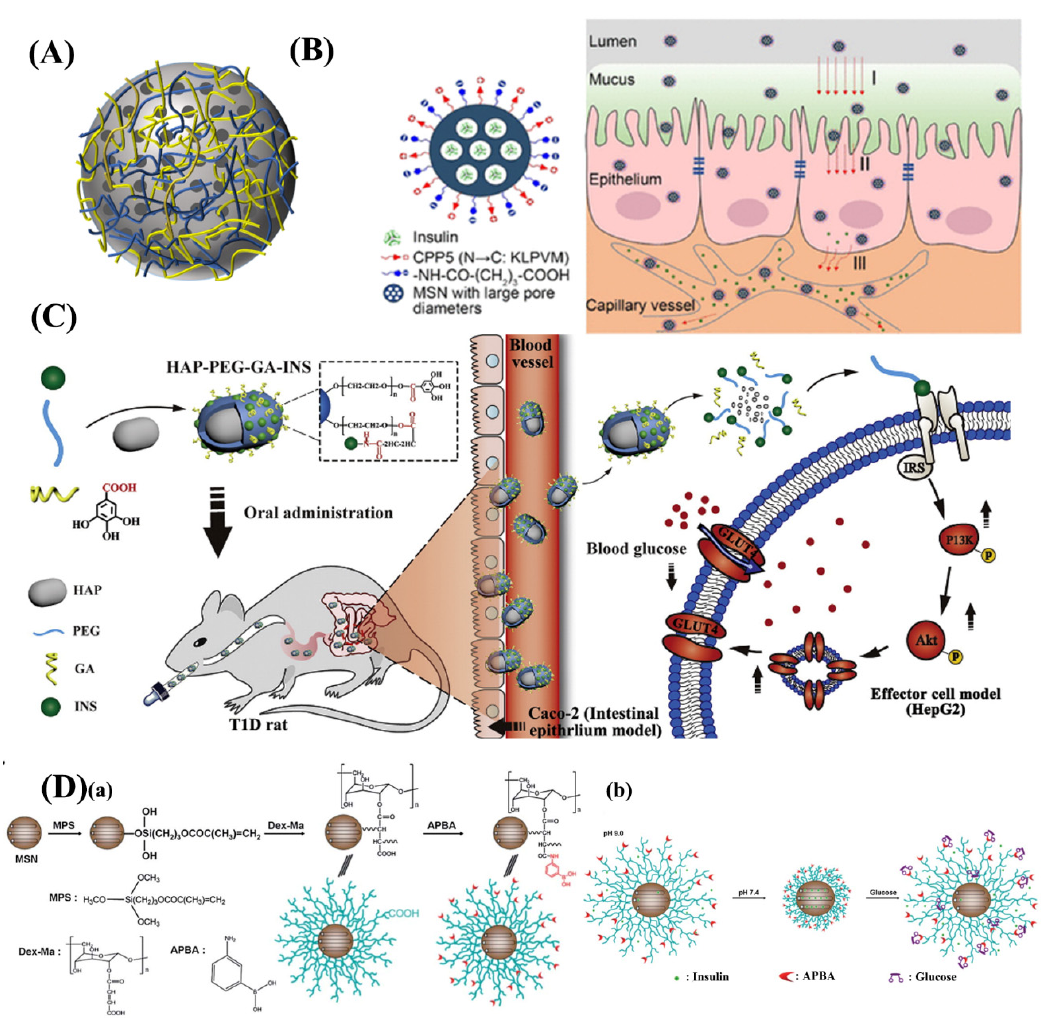
Figure 8. ( A ) Structure of inorganic/organic hybrid. ( B ) Structure of penetration behavior of virus- mimicking nanoparticles (MSN-NH2@COOH/CPP5). ( C ) Structure of HAP-PEG-GA-INS NPs and schematic diagram of insulin delivery to the effector cells by HAP-PEG-GA-INS NPs. ( D ) Structure and synthesis of the MSNs core–shell nanoparticles ( a ) and its pH- and glucose-sensitive behavior ( b ).